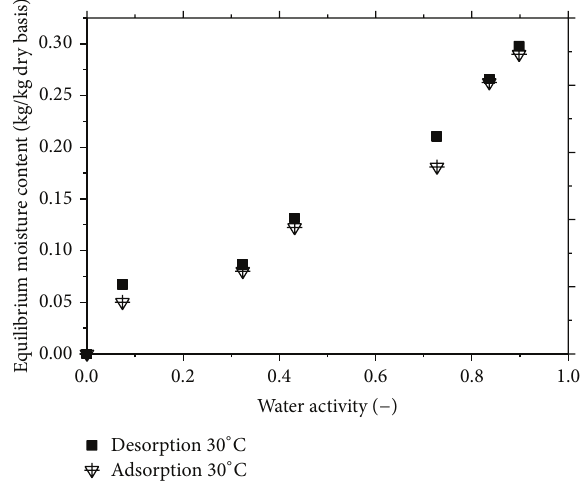
Figure 1: Desorption and adsorption isotherms of Ziziphus spina- christi leaves obtained at 30 ∘ C. Des: desorption; Ads: